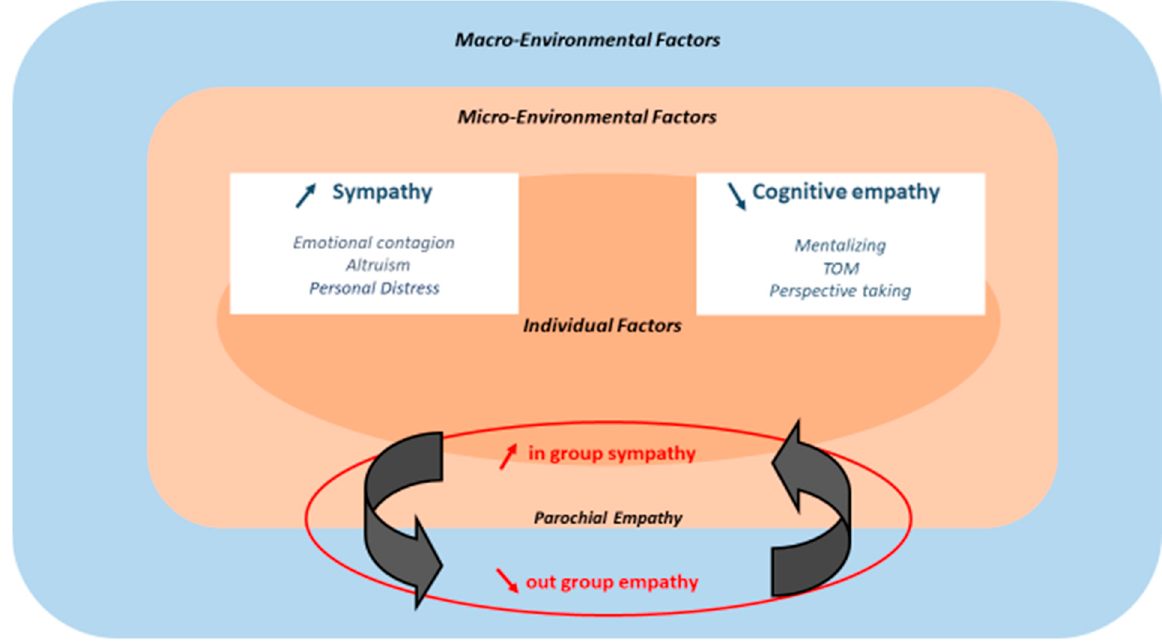
Figure 1. The double dissociation model of sympathy/empathy in youth radicalization. The model shows how sympathy/empathy may change during radicalization with a dissociative mode combining increased sympathy (emotional sharing and affective contagion) and decreased empathy (the cognitive ability to feel what the other feels) according to the sympathy/empathy status at the baseline and specific trajectories summarized in Figure 2.